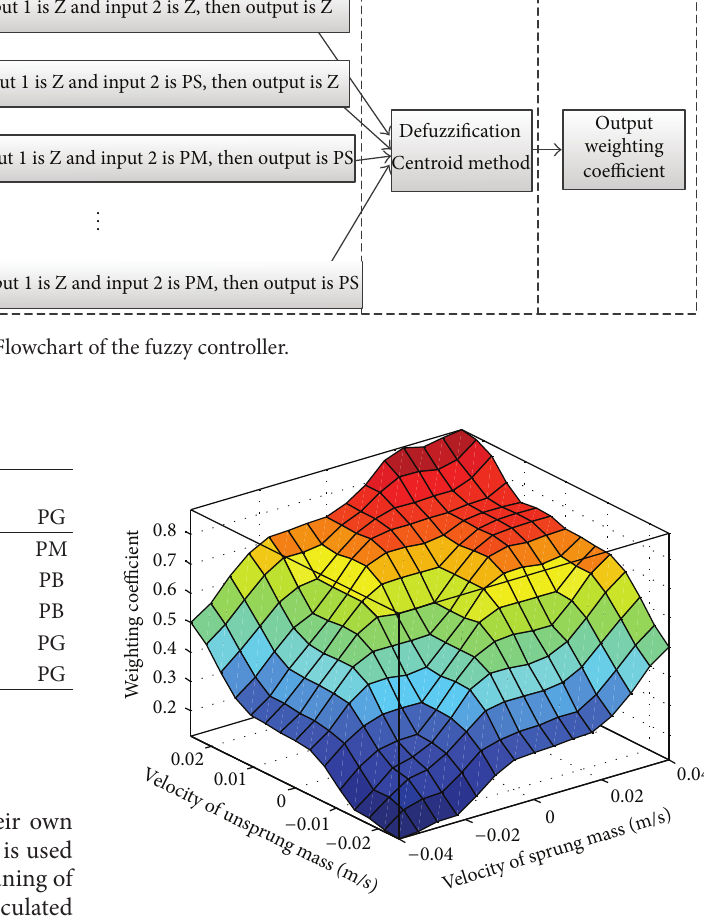
Figure 8: Compositional rule of inference for the fuzzy